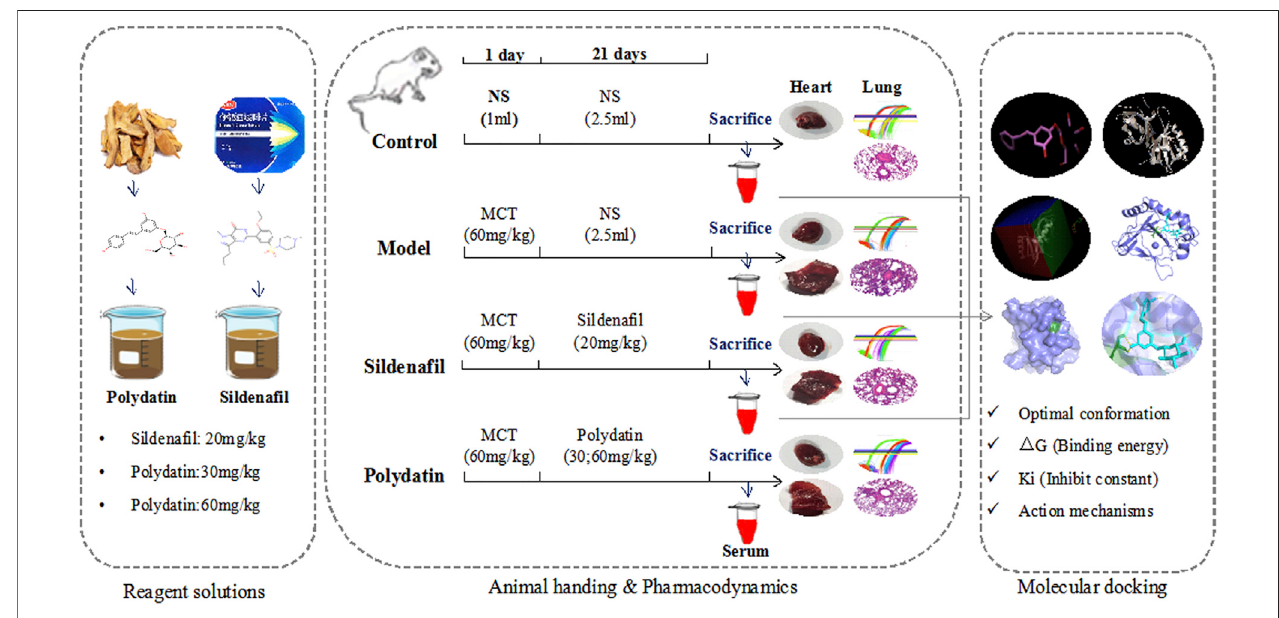
FIGURE 1 | Scheme of the